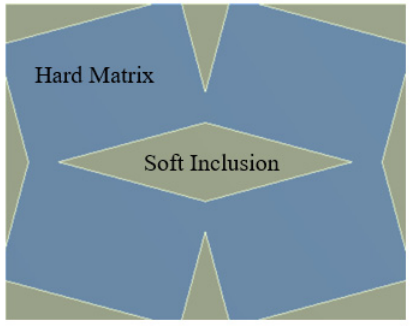
Figure 2. The unit cell comprises a hard matrix and soft inclusions.